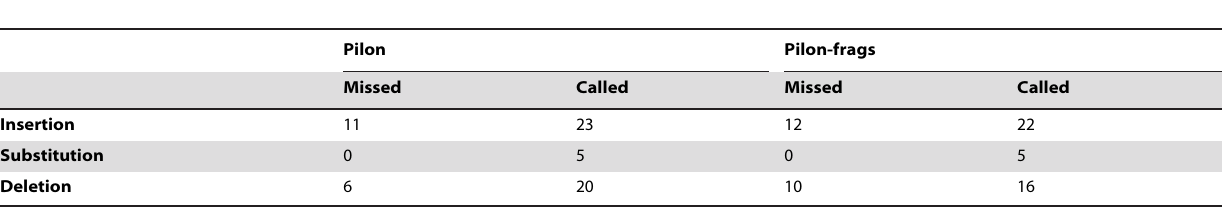
Table 4. Pilon’s performance in calling variants in M. tuberculosis F11 that were larger than 50 nt.